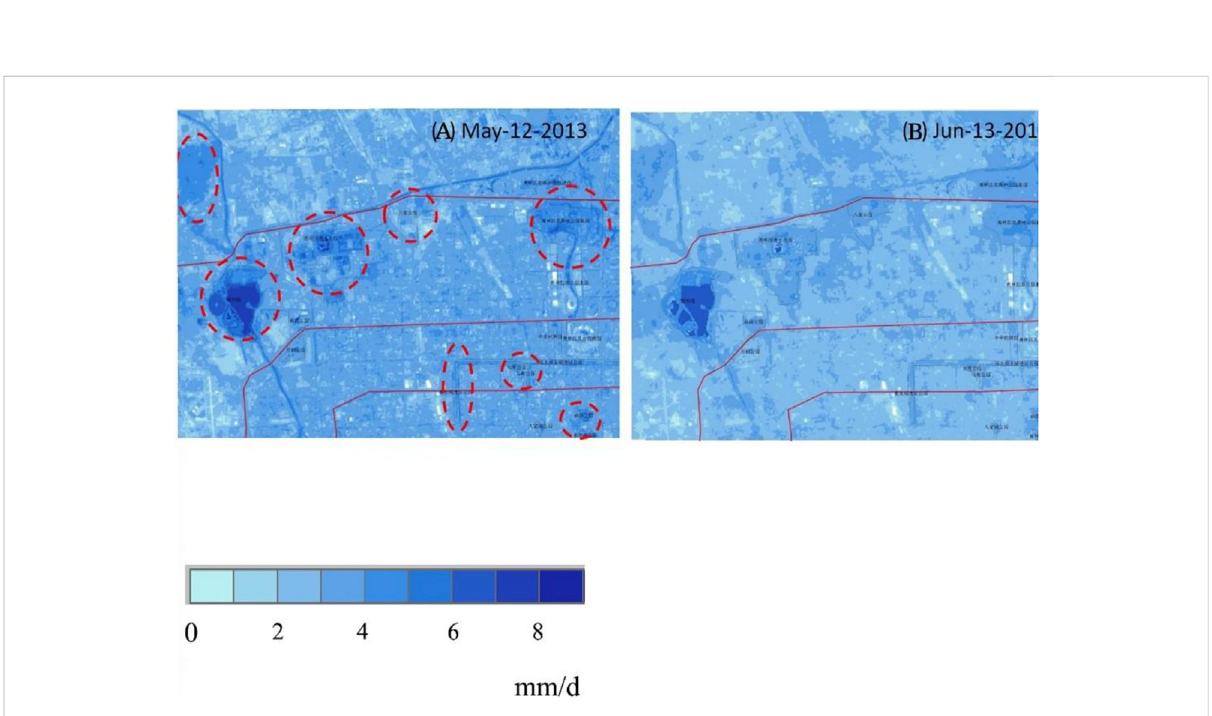
FIGURE 3 Dynamics of evapotranspiration patterns in the study area during (A) May and (B) June, 2013 based on surface energy balance method using Landsat-8 satellite data. Each date had different